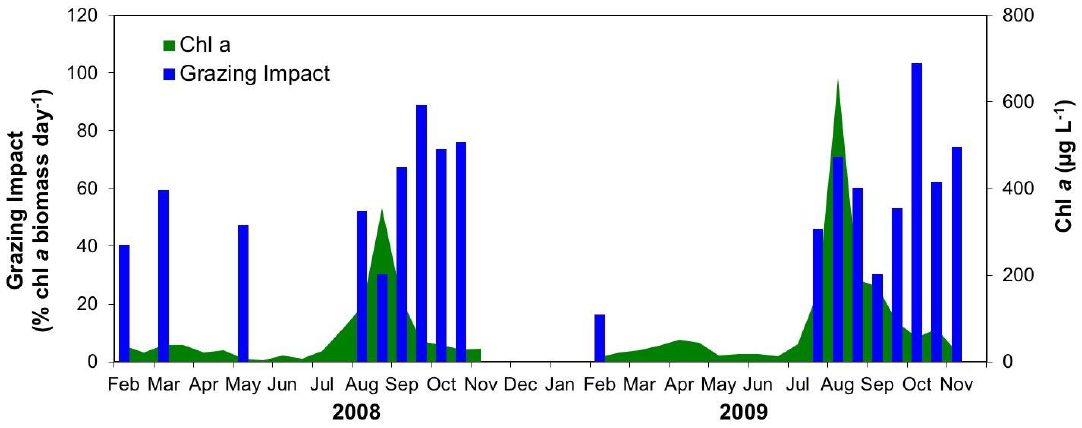
Figure 10. Microzooplankton grazing impact (blue bars), measured as the % of phytoplankton standing stock consumed per day, determined from dilution experiments conducted in Vancouver Lake from February 2008 to November 2009. Green area represents chl a concentration over the same period. Data from G. Rollwagen-Bollens et al. (unpublished).